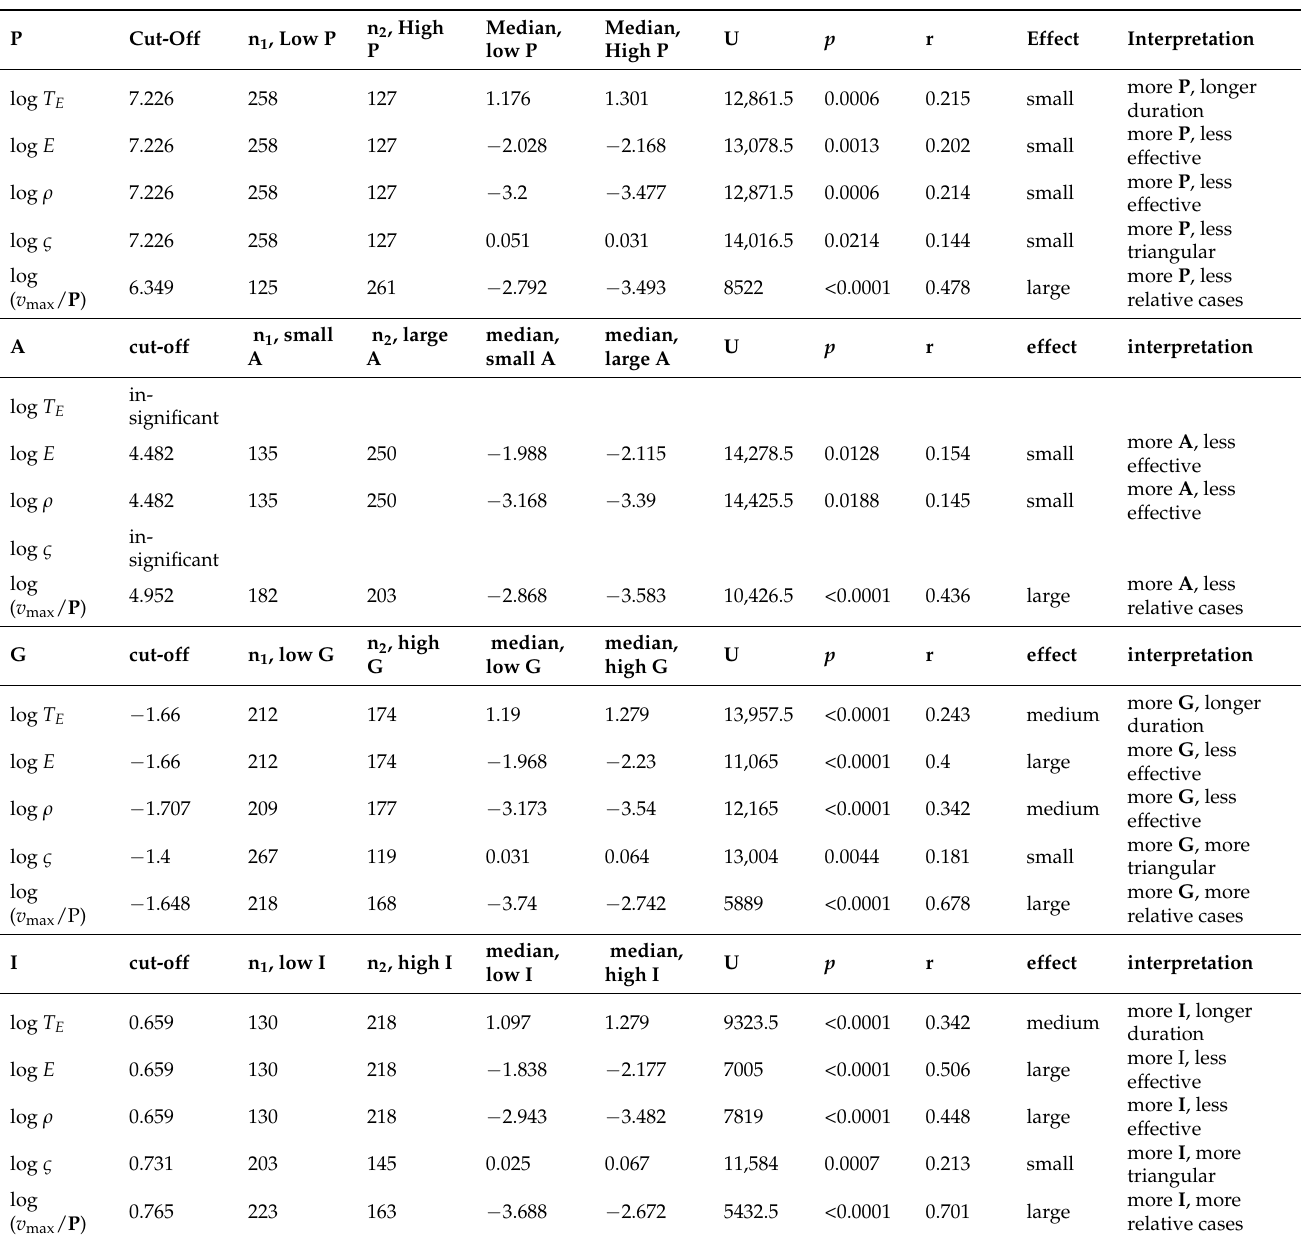
Table 5. Relationship between epidemiological parameters and geographical and socioeconomic data across all Omicron waves ; P = population; A = land area; G = GDP per capita (GDP/ P ); I = ed- ucational index; D = population density ( P / A ); T E = duration of the effective phase; E = effectiveness; ρ = E / T E and log ς = wave shape factor; v max = peak velocity; v max / P = peak velocity per population P ; cut-off = value of P , A , G , I , or D that divides, e.g., P into two subsamples of low and high P with associated, e.g., E -values that are significantly different at the lowest possible p -value (cf. Figure 3c,d); n 1,2 = sample sizes for the Mann–Whitney U test; U = U-statistic value of the Mann–Whitney test; p = probability value; r = effect